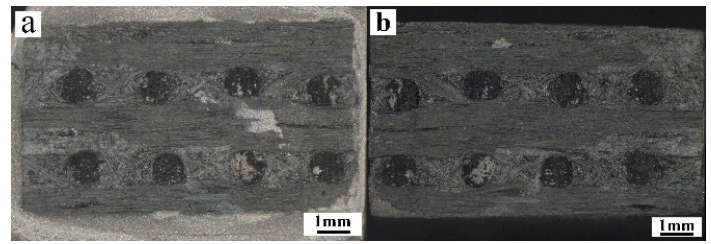
Figure 8. OM macroscopic fracture morphology of brazed joint: ( a ) TiAl side, ( b ) C/C composite side.